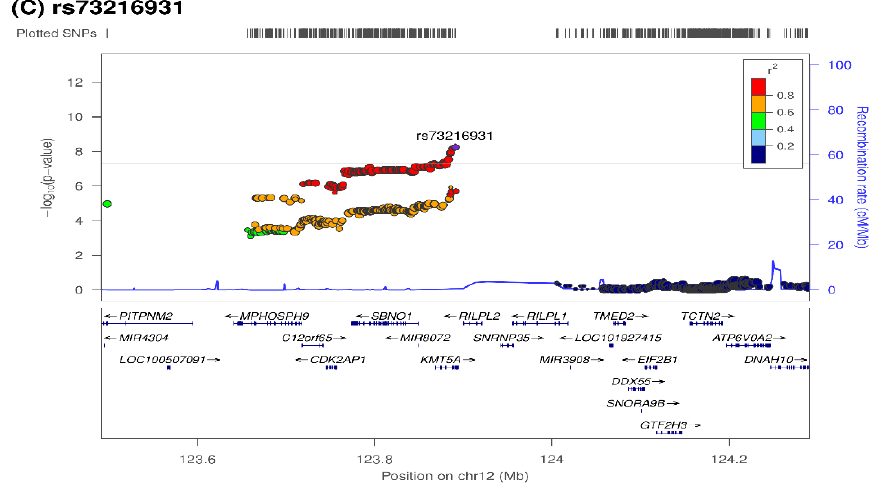
Figure 4. Regional plot of associated SNPs with genome-wide significance. Table 4. Differentially expressed genes at the significant loci for ApoA1 in the Gene Expression Omnibus GSE53201 database.